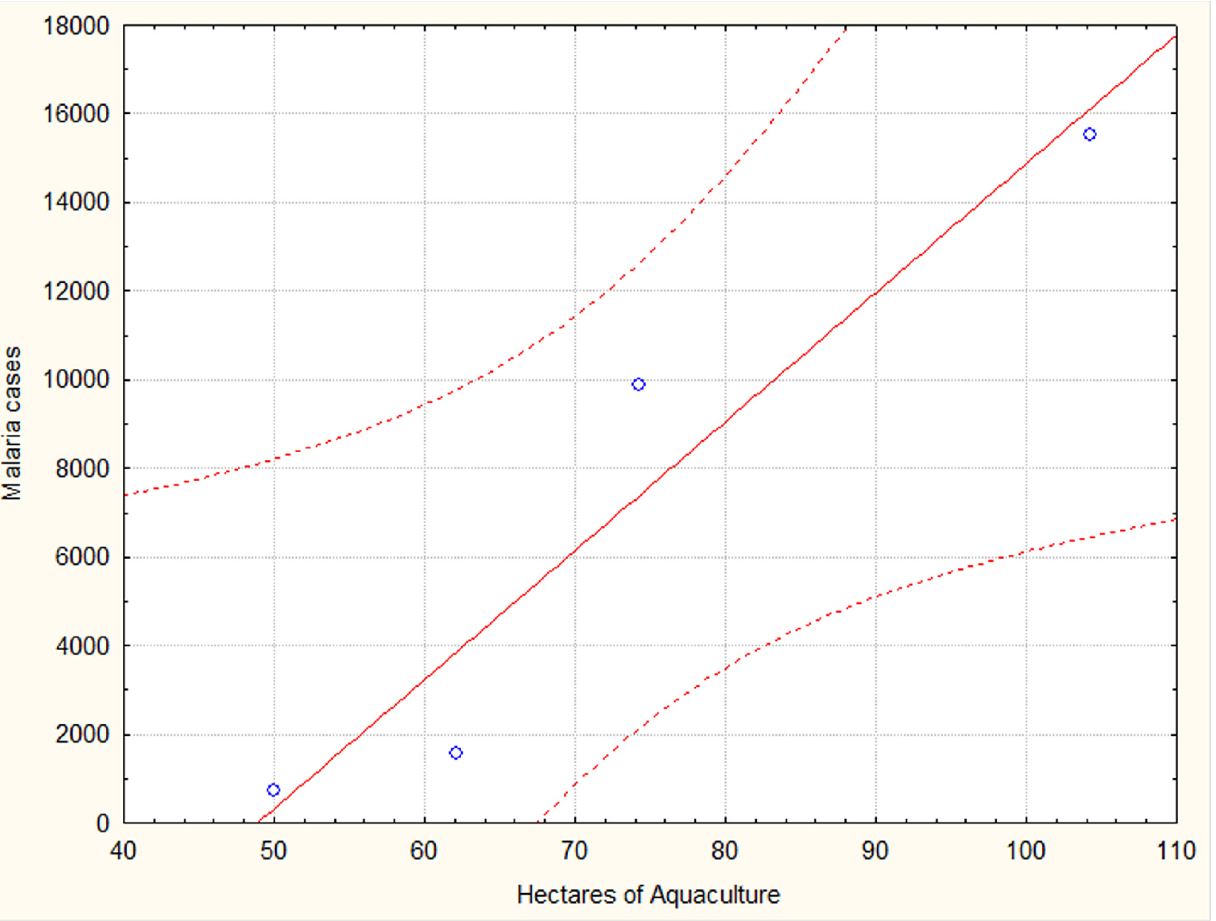
Fig 5. Number of hectares of aquaculture in Mâncio Lima estimated from harvest data in 2003 to 2006, as related to the number of malaria cases in the